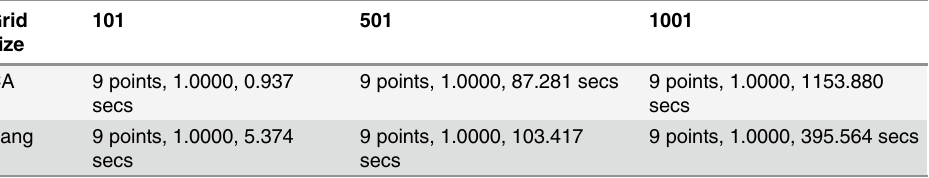
Table 5. Number of support points in the generated designs from the Cocktail and Optimal Weights Exchange algorithms using different grid sizes, their relative D -efficiencies and CPU times for the Becker ’ s Model